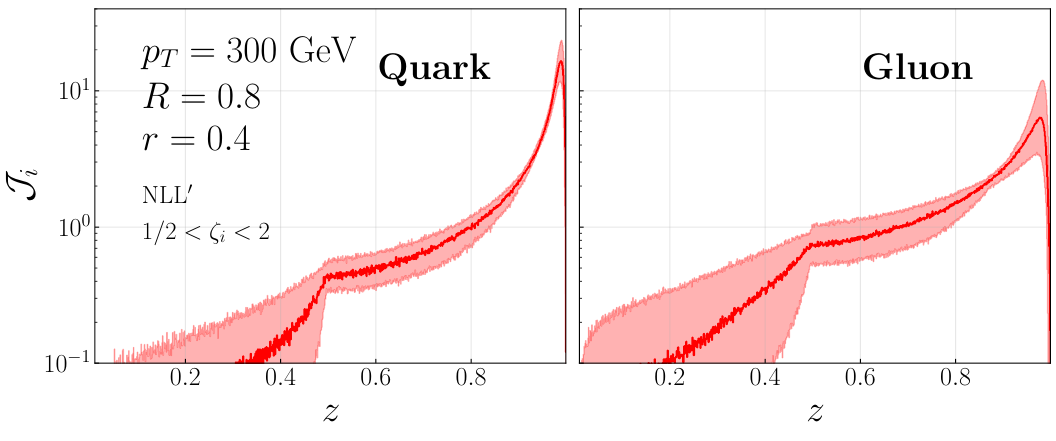
Figure 8 . Cross section for inclusive and leading subjets using a linear (left) and logarithmic scale √ (right). We show the result for s = 13 TeV proton-proton collisions and exemplary values of the jet